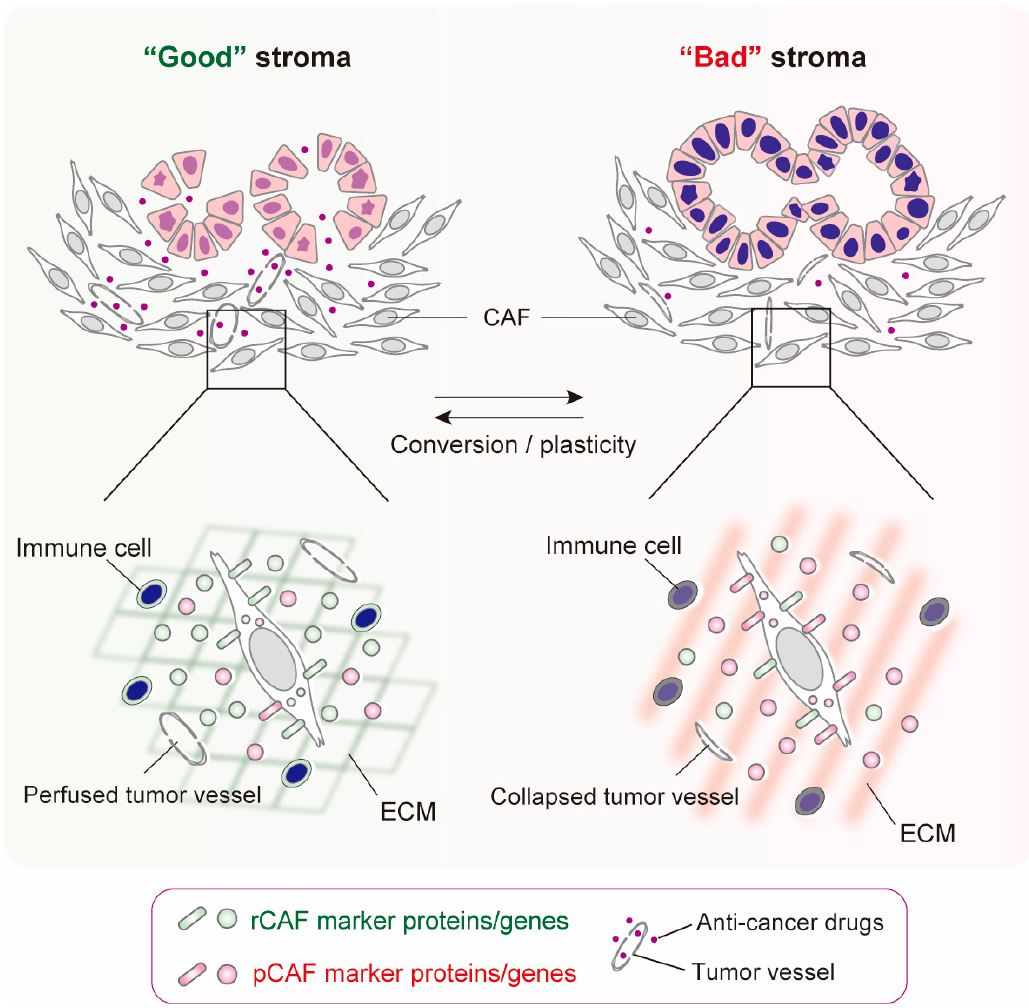
Figure 4. Hypothesis regarding the states of CAFs that determine the properties of the stroma of PDAC. The state of individual CAFs may be regulated by the balance between the expression of rCAF and pCAF marker proteins, which results in the formation of good (left) or bad (right) PDAC stroma. Good and bad stromata affect the properties of tumor vessels and immune cells, which determine the progression and drug sensitivity of PDAC. Recent studies have suggested that rCAFs and pCAFs are plastic and can be converted into each other during disease progression and pharmacological interventions [21,43].